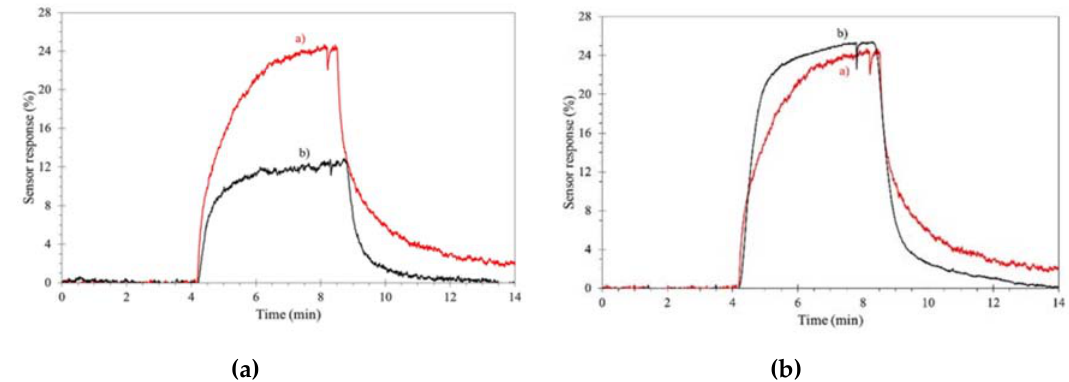
Figure 5. Effect of an ionic liquid (IL) ‐ composed filter on aromatic volatile compound detection. Sensor response under 500 ppb compounds. ( a ): dry air; ( b ): wet (50%) air. Left, without filter, right with filter. Reproduced with permission [118]. Copyright 2018, ISFA.